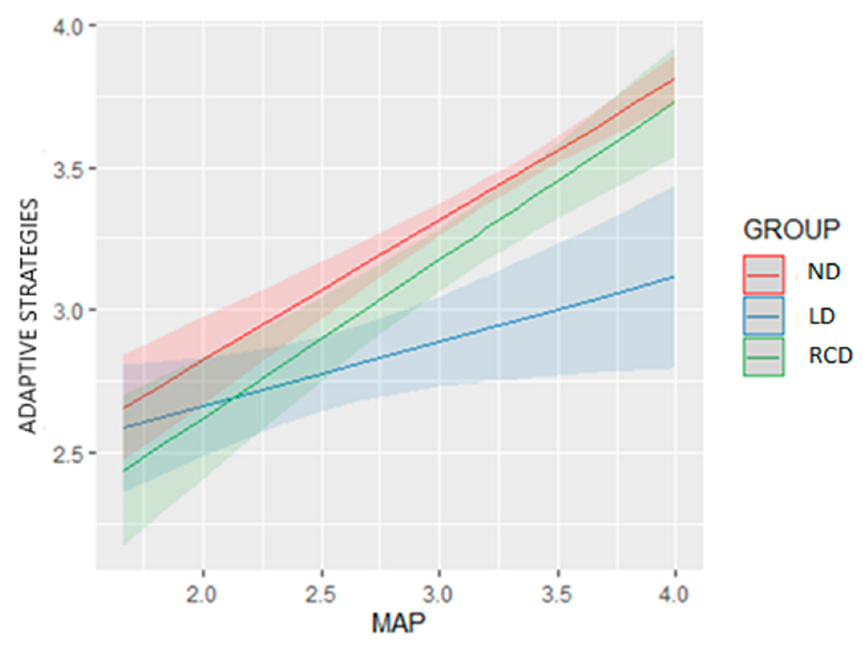
Figure 2. Interaction effect of MAP goals and Groups on Adaptive Strategies.